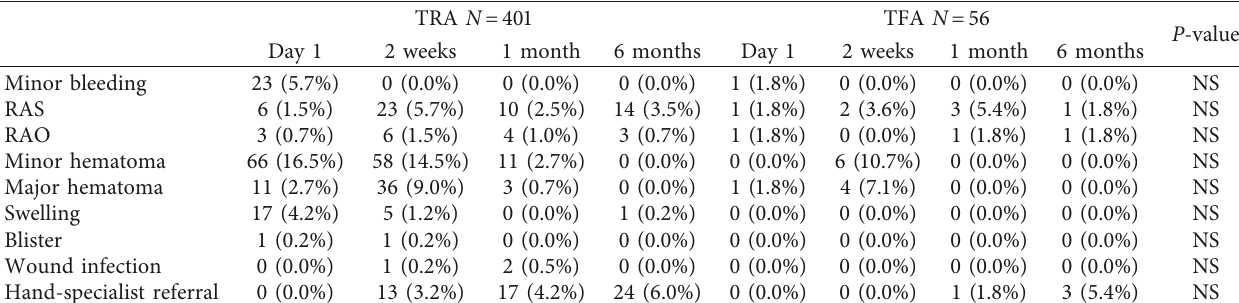
Figure 2: Longitudinal strength measurements. Longitudinal evolution of strength measurements for both extremities in the transradial ((a) n � 404) and transfemoral ((b) n � 53) groups. Values are median ± IQR. Values are normalized per patient by each baseline measurement. The horizontal gray dotted line indicates “no change.” The single y -scale holds for all graphs per subplot. Change with respect to baseline is indicated at the posttreatment timepoints, and with respect to the previous time point in between the posttreatment timepoints, measured with Wilcoxon signed-rank test and Holm–Bonferroni correction. ‡ p < 0 . 01 and † p < 0 . 05. Table 4: Access-site complications following percutaneous coronary